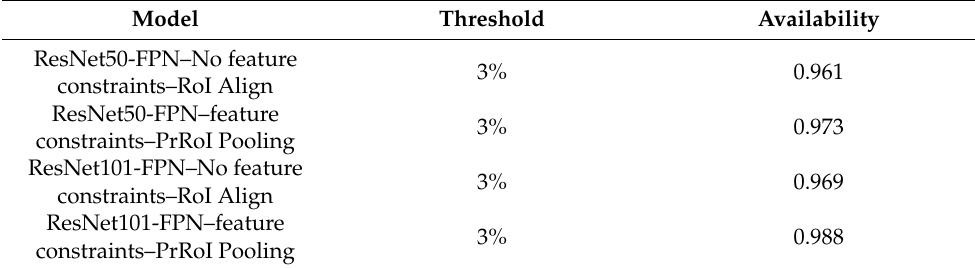
Table 5. Availability of different